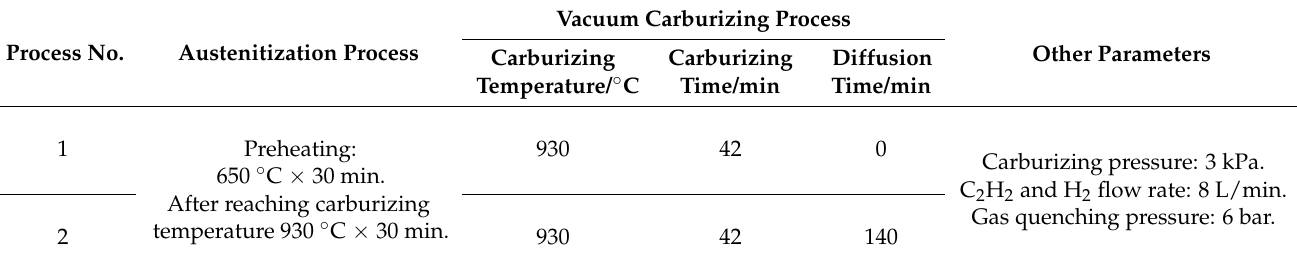
Table 3. Vacuum carburizing process scheme.